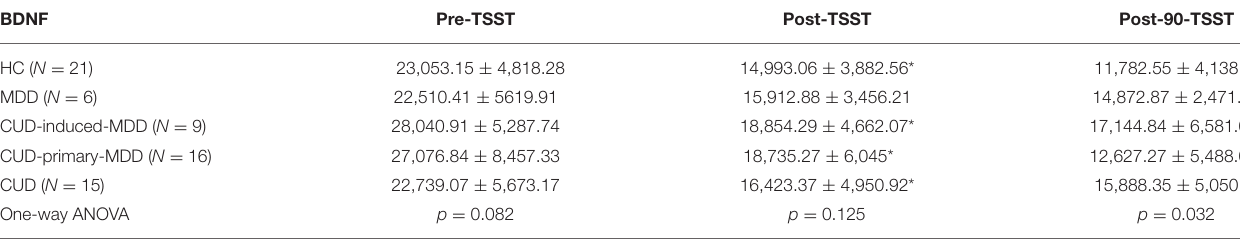
TABLE 4 | Mean BDNF concentrations during Trier social stress test (TSST).